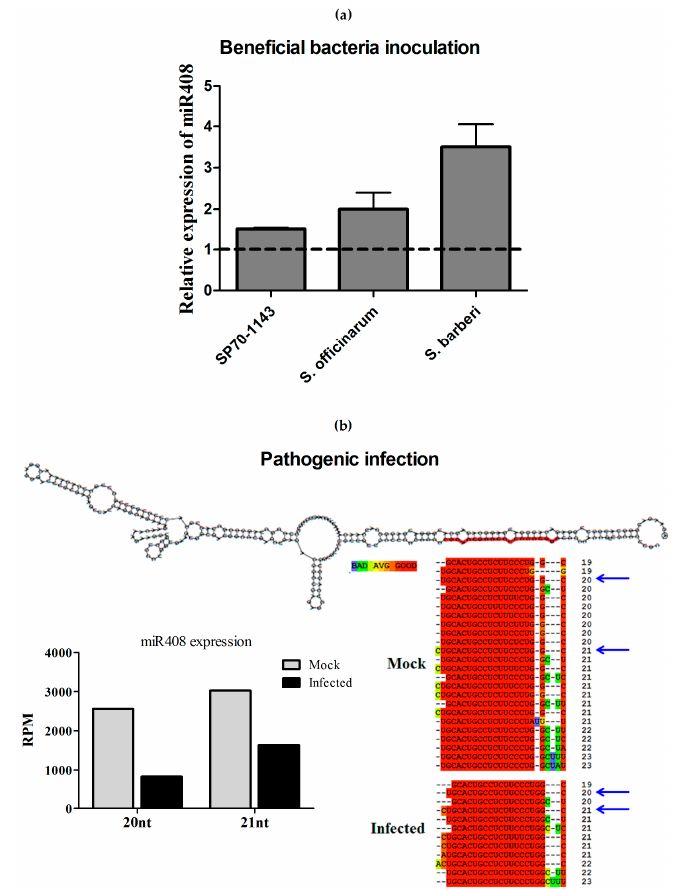
Figure 8. Analysis of miR408-regulation. ( a ) Sugarcane hybrid SP70-1143 and two wild species were used to verify the relative expression of miR408 in response to inoculation with the beneficial diazotrophic bacteria Gluconacetobacter diazotrophicus (GD) using quantitative Reverse Transcription- PCR (qRT-PCR). The error bars represent the standard deviation between three technical replicates. * represents significant differences in expression between the control and inoculated samples for each experiment ( p -value < 0.05); ( b ) Different members of the miR408 family aligned in the same position at their precursor and in the expression profiles of the two more expressed sequences obtained from bioinformatics analysis. These mature sequences were found in mock and infected libraries, and the blue arrow shows the more abundant